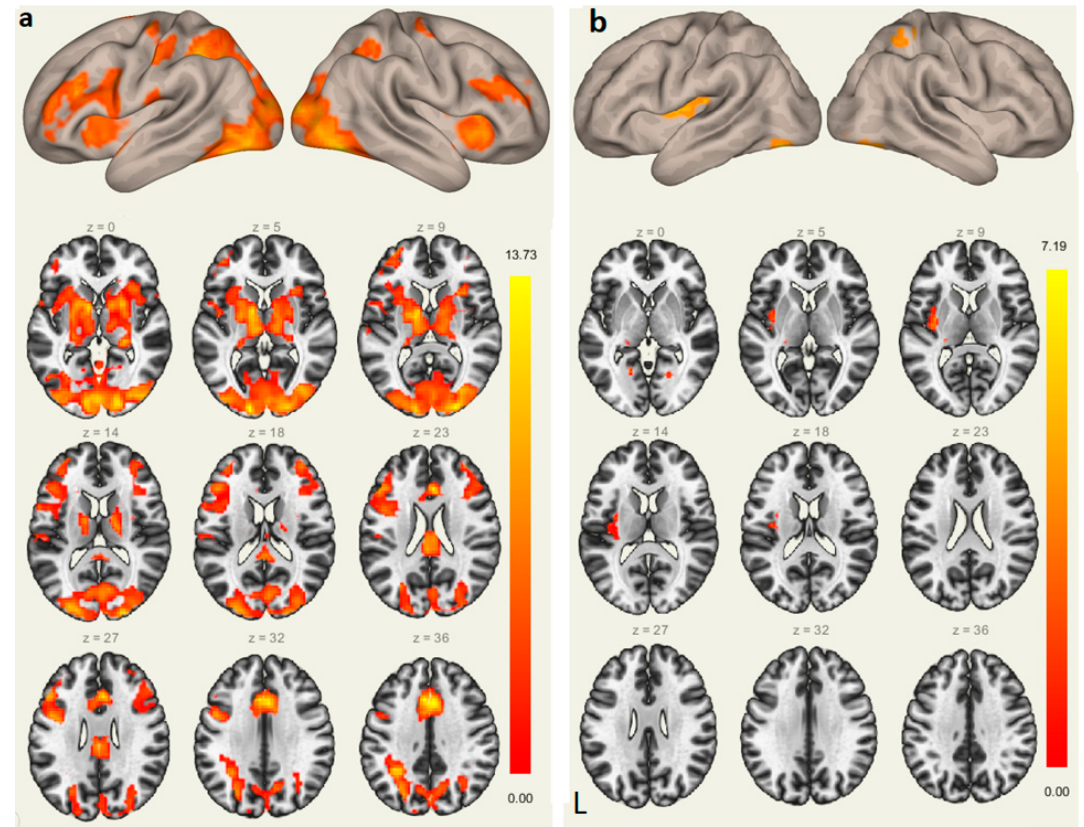
Figure 3. Brain activations during the sound-picture association judgment task ( a ); Brain regions where neural responses were positively related with participant’s L2 vocabulary learning attainment (accuracy rates of the sound-picture association judgment task) ( b ). L, left hemisphere.